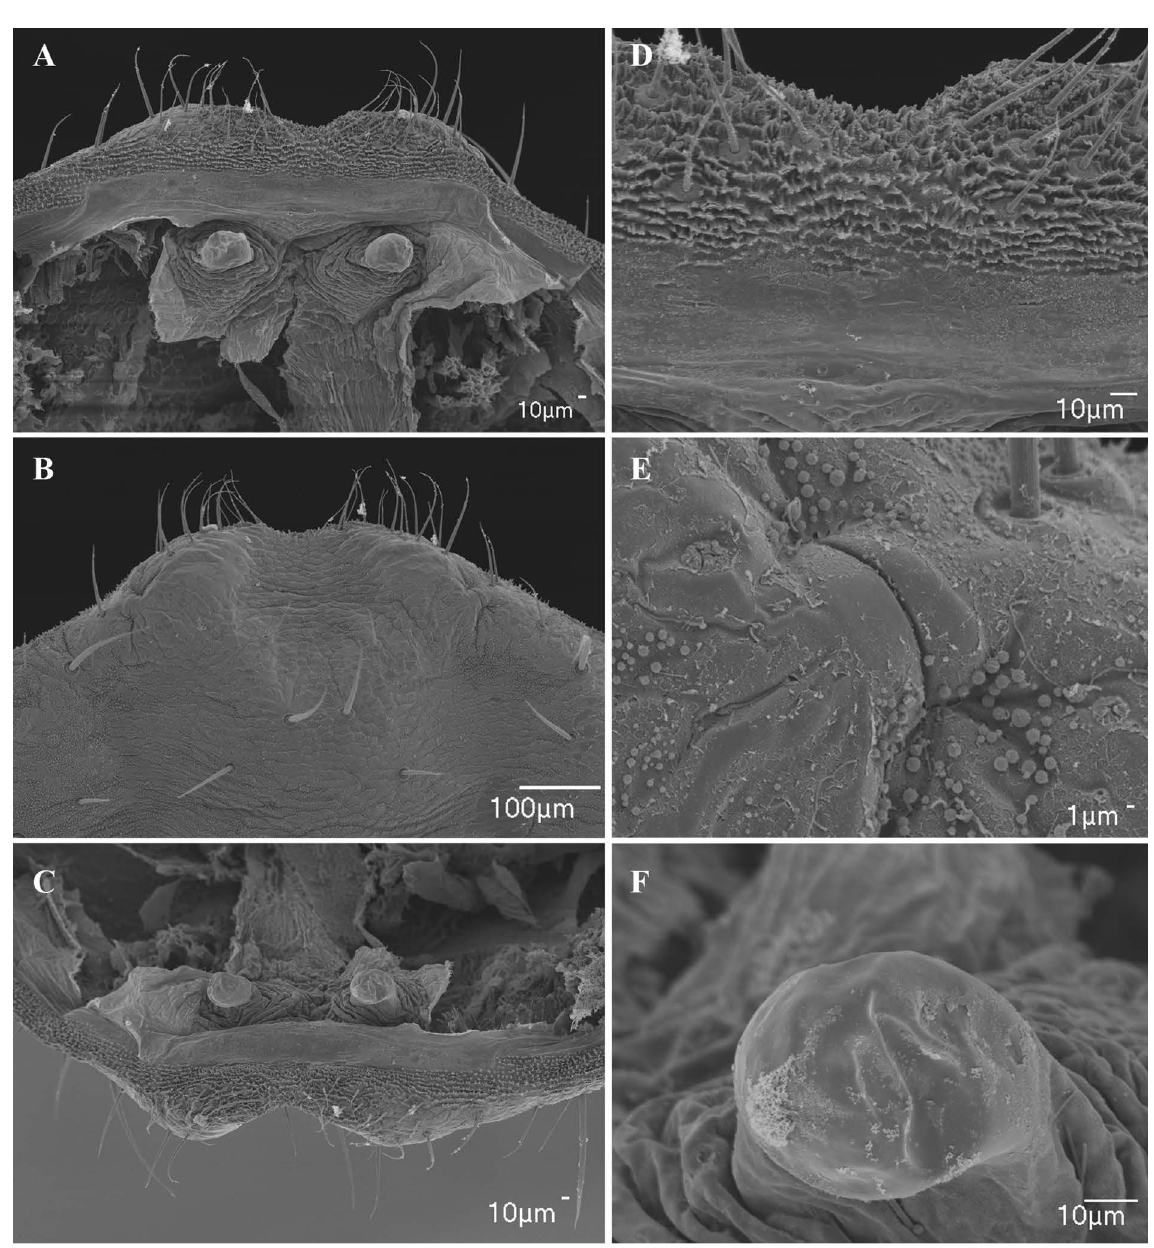
Fig. 121. Sarax rahmadii sp. nov. (WAM T63210), female gonopod and genital operculum. A . Gonopod, dorsal view. B . Genital operculum, ventral view. C . Gonopod and genital operculum, posterior view. D . Posterior margin of genital operculum. E . Gland on genital operculum, ventral view. F . Apex of sinistral